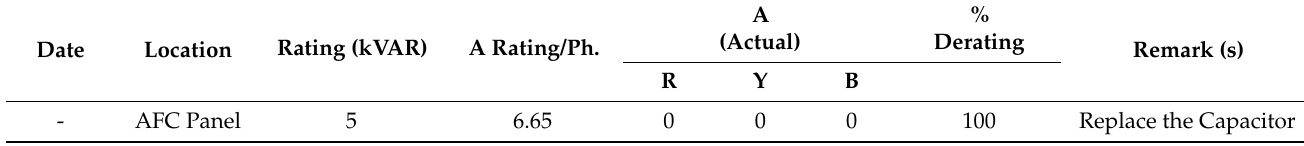
Table 6. Proposed log sheet for capacitor checking and